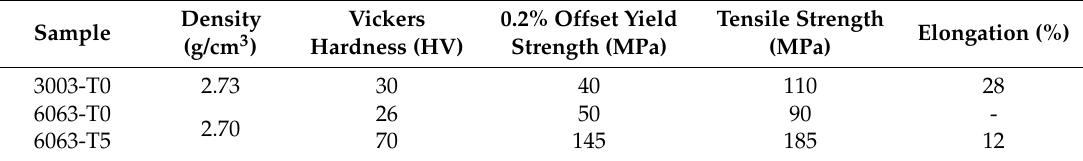
Table 2. General specifications of mechanical properties of Al6063 and Al3003